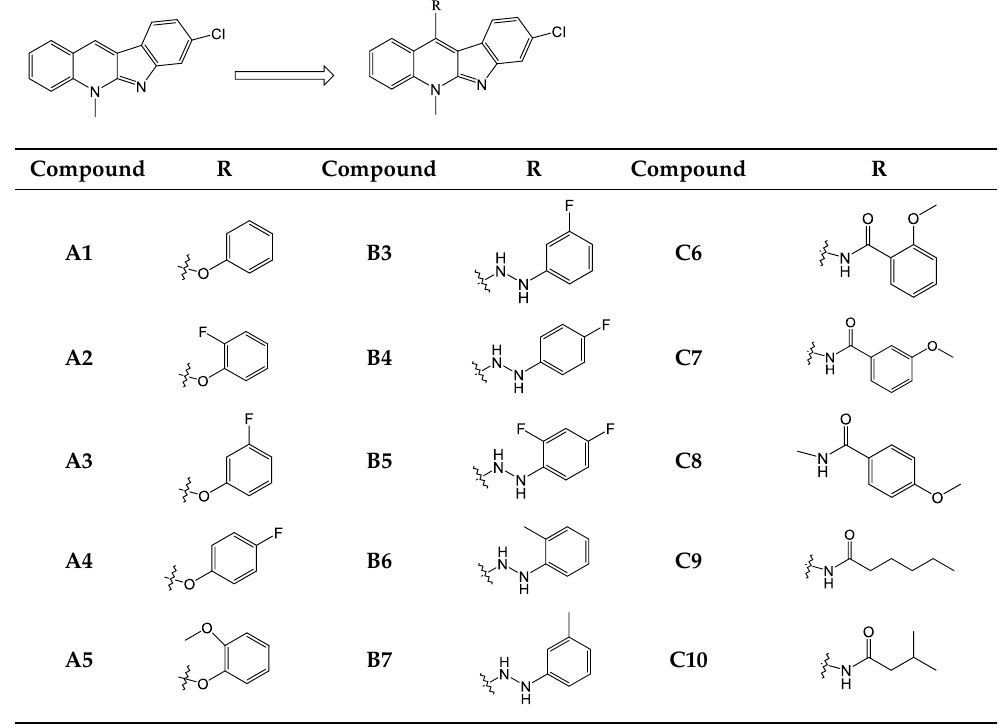
Table 1. Chemical structures of neocryptolepine derivatives.